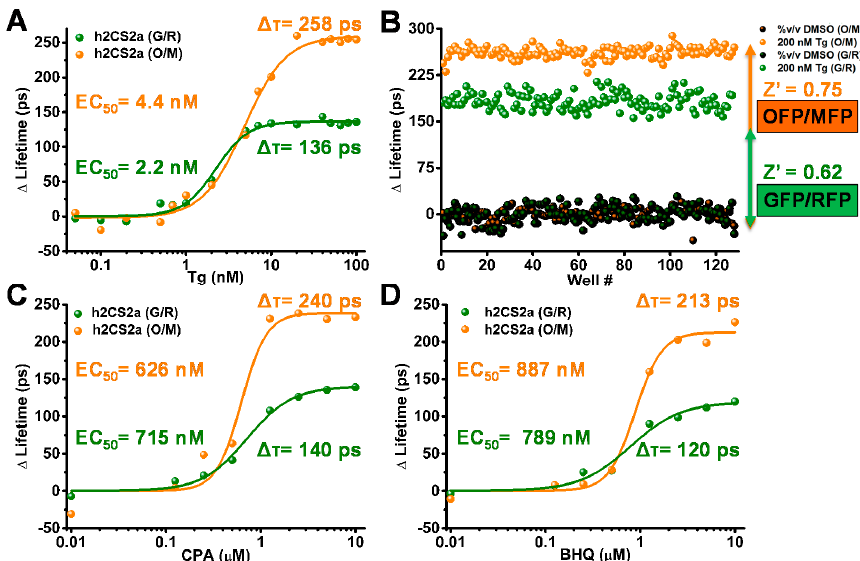
Figure 3. Concentration-response curves (CRC) and Z ′ comparison of known small-molecule SERCA effectors. ( A ) 16-point concentration-response curves show that thapsigargin, a specific SERCA inhibitor, induces a larger lifetime change for O/M (orange) than for G/R (green). ( B ) Z ′ analysis of 2CS incubated with saturating dose of 200 nM Tg from 128 wells of a 1536-well-plate shows a larger response for O/M than for G/R. ( C , D ) 8-point CRC shows that SERCA inhibitors cyclopiazonic acid (CPA) and 2,5-di-t-butyl-1,4-benzohydroquinone (BHQ) also induce larger lifetime changes for O/M than for